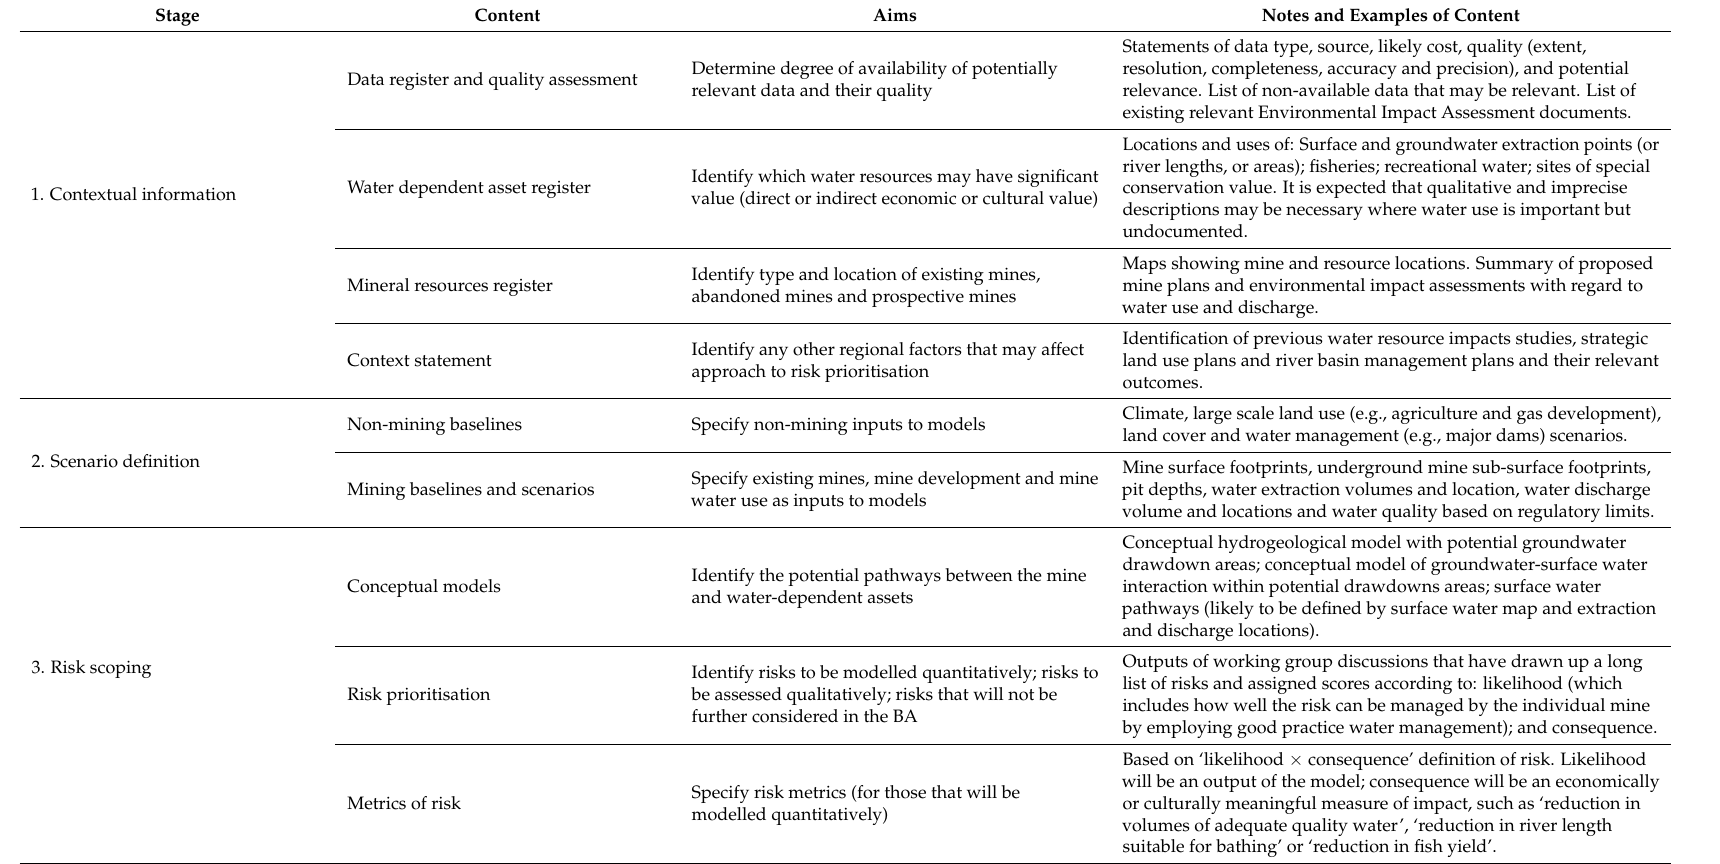
Table 1. Stages of a proposed Strategic Assessment of Regional Water Impacts of Mining for Colombian mining